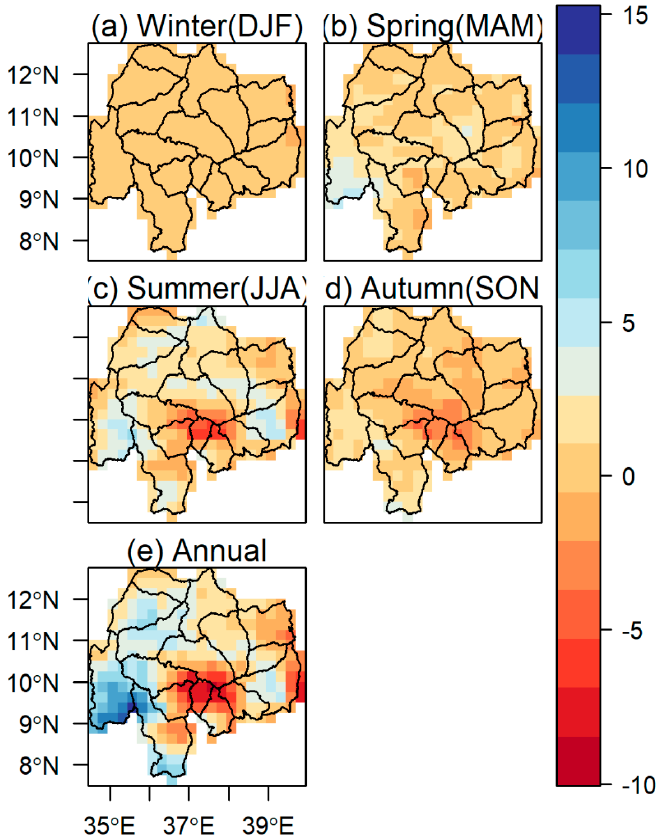
Figure 8. Standard rainfall anomalies for annual rainfall in the UBNB indicating the magnitude of departure from long-term mean rainfall over a period of 26 years observation (1992–2017). A negative value represents periods of below-normal rains (drought), while positive values indicate above-normal rains (with the possible risk of flood).